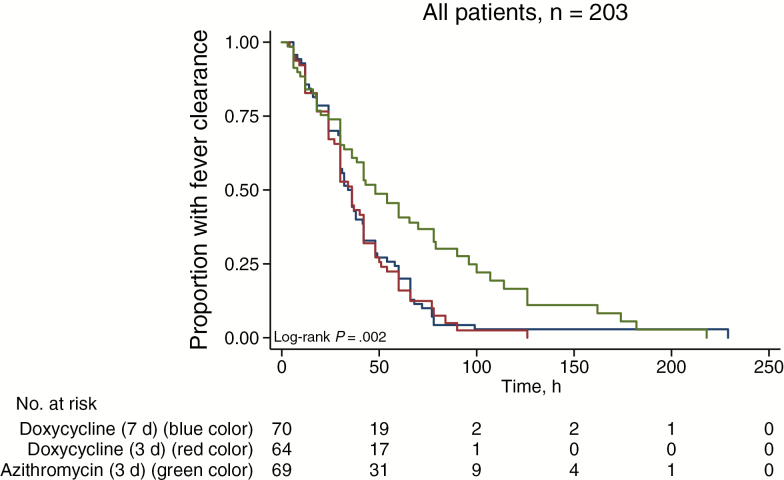
Kaplan-Meier plot of fever clearance for all patients who presented with or developed fever (n = 203).